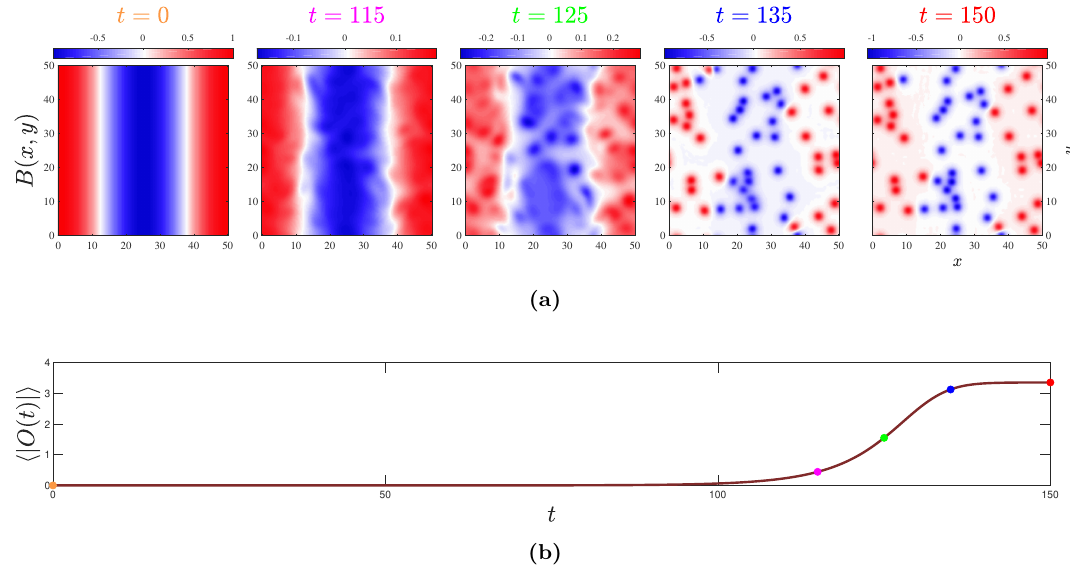
Figure 2. Time evolution of the magnetic field and the birth of topological defects. (a) Density plots of the evolving magnetic field at five specific times ( t = 0 , 115 , 125 , 135 , 150 ) with τ Q = 20 and B 0 = 1 . One can see how the initial plane-wave magnetic field evolves to the clusters of equal-sign vortices. The red (blue) localized points in the equilibrium state ( t = 150 ) represent positive (negative) magnetic fluxoids; (b) The growth of the average order parameter from initial time to final equilibrium state. Five colored points correspond to the five snapshots in panel (a), respectively. The order parameter scrambles during the period t ≈ [100 , 135] . Related animations can be found in the movie